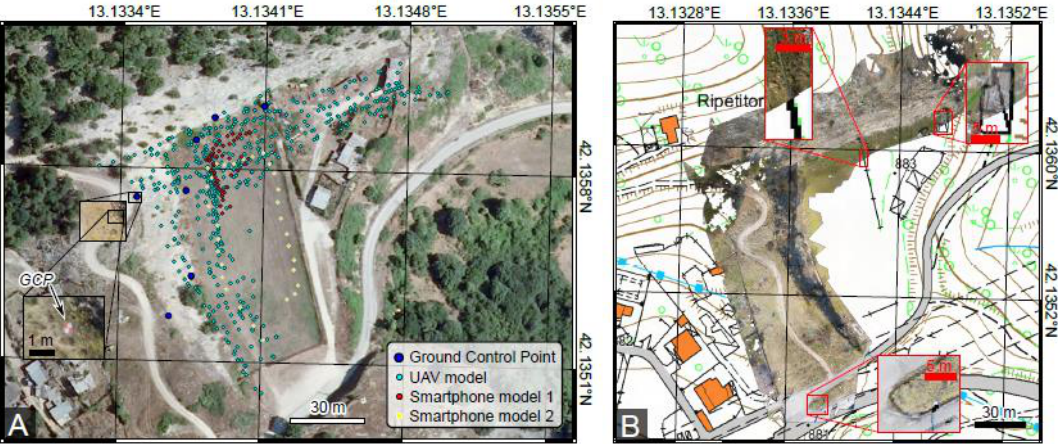
Figure 3. The Pietrasecca site and models. ( A ) orthophoto of the Pietrasecca football field, with location of photographs used in the UAV and smartphone models, as well as the ground control points used for UAV model registration. ( B ) Comparison between the orthophoto derived from the UAV model and the o ffi cial 1:5000 topographic map (http: // geoportale.regione.abruzzo.it / Cartanet / viewer), with details showing the degree of coincidence between the two datasets.